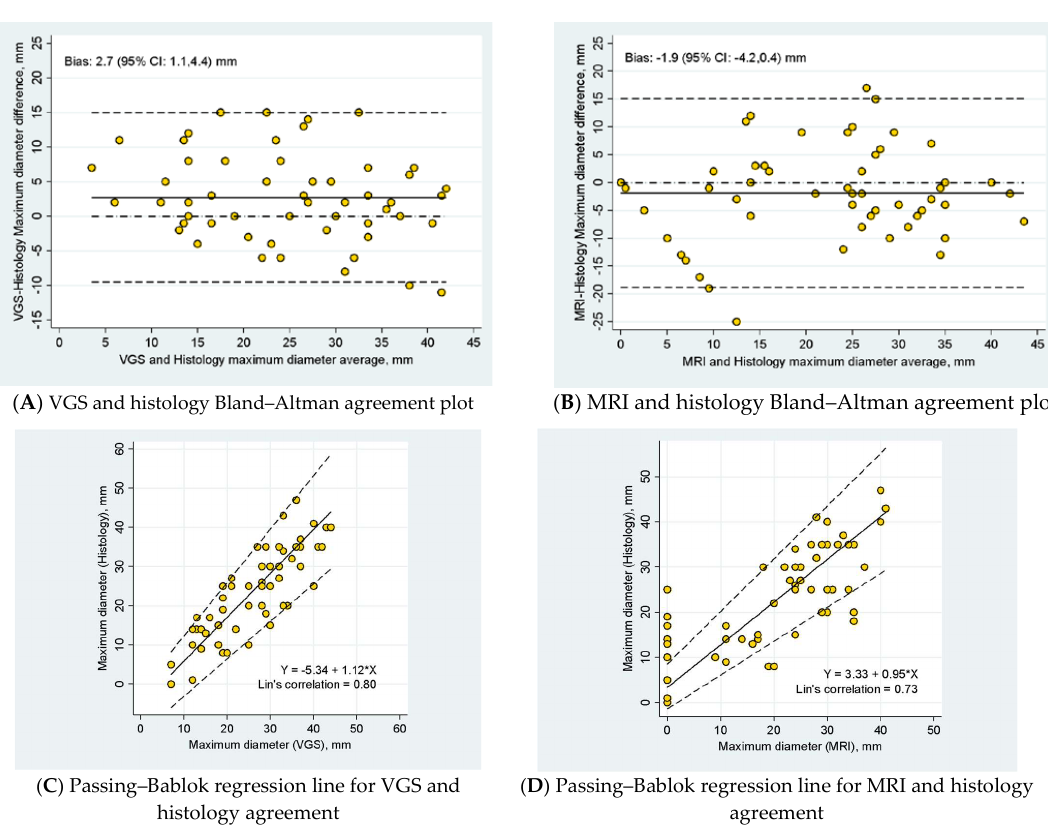
Figure 5. Bland–Altman plot of both methods compared with the gold standard.